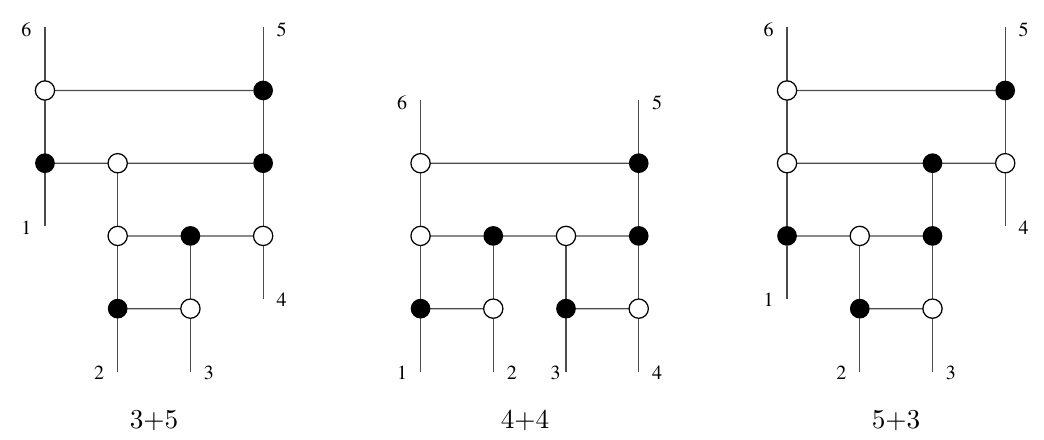
Figure 10 . On-shell diagrams contributing to the 6-point NMHV amplitude in N = 4